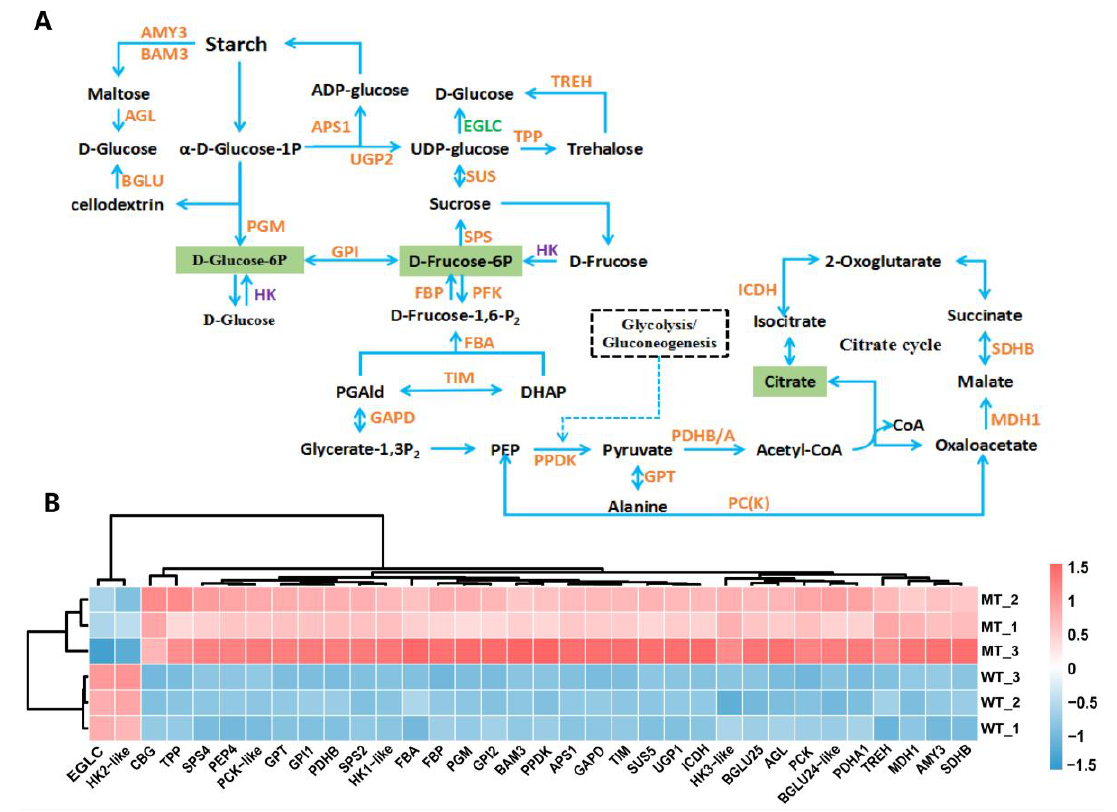
Figure 9. Central carbon metabolism pathway ( A ) and relative expression level of DEGs ( B ). CBG, cyanogenic beta-glucosidase-like(Glyco_hydro_1); SPS4, sucrose-phosphate synthase; BGLU,